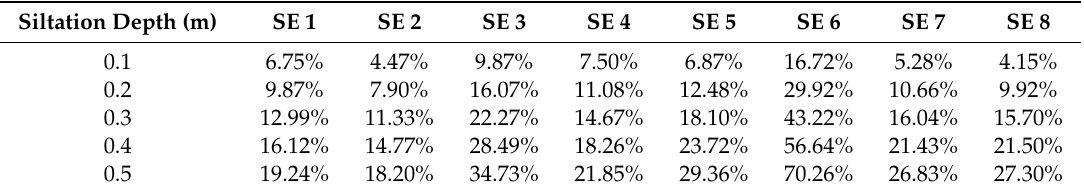
Table 3. Reduction ratio of e-flow requirement for di ff erent river segments (SE) under the high hydrological connectivity scenario with a specified flow velocity of 0.1 m / s.